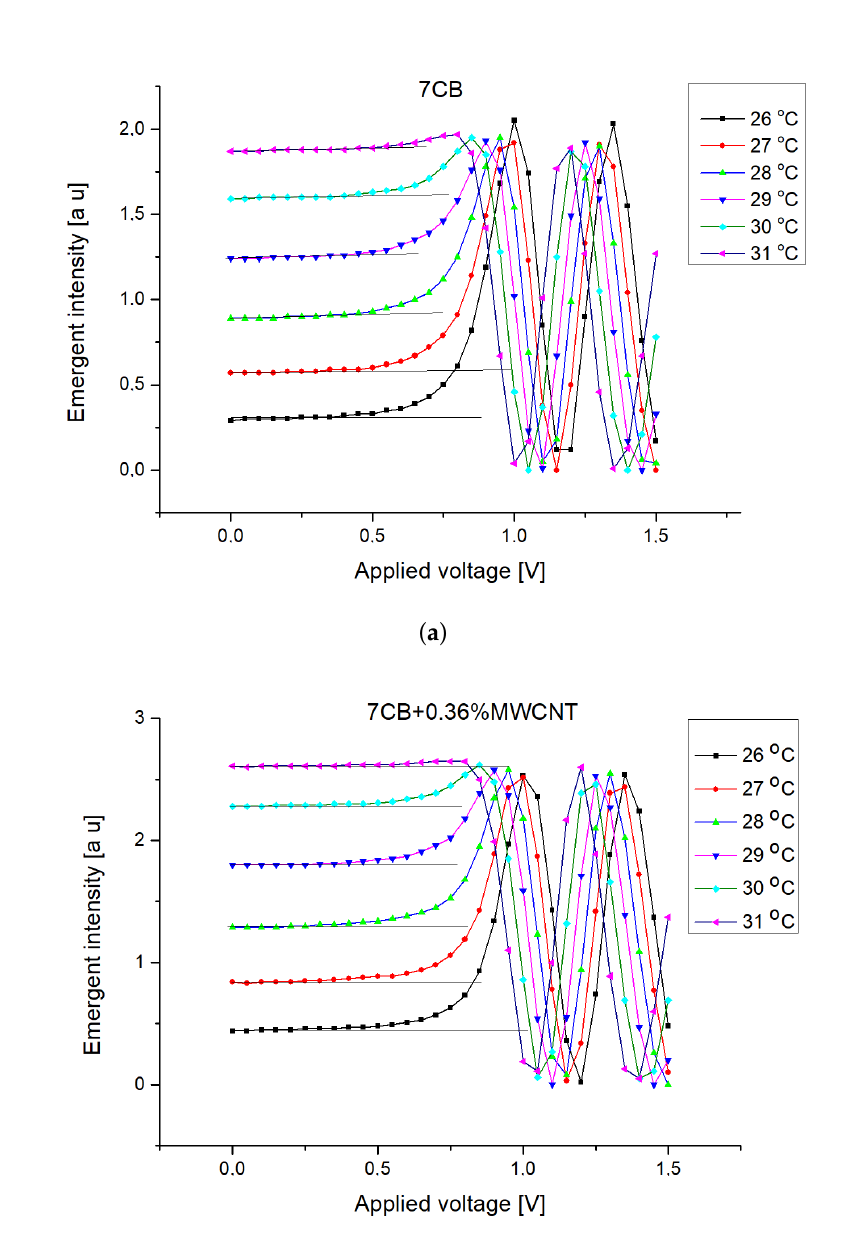
Figure 6. Emergent intensity versus applied voltage plots ( a ) for 7CB and ( b ) for 7CB + 0.36%